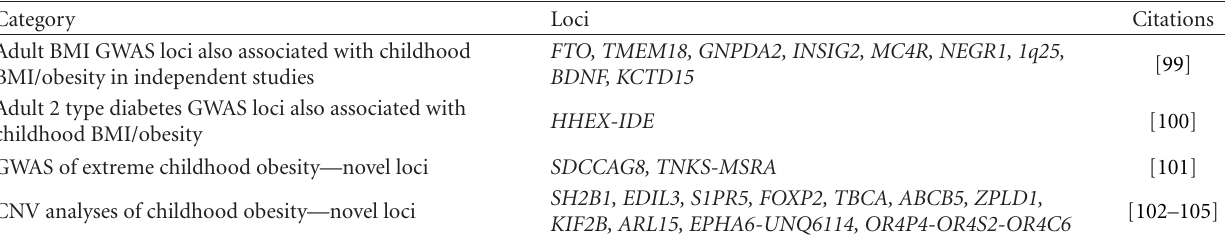
Table 1: Childhood obesity loci that have been identified to date and the route through which they were